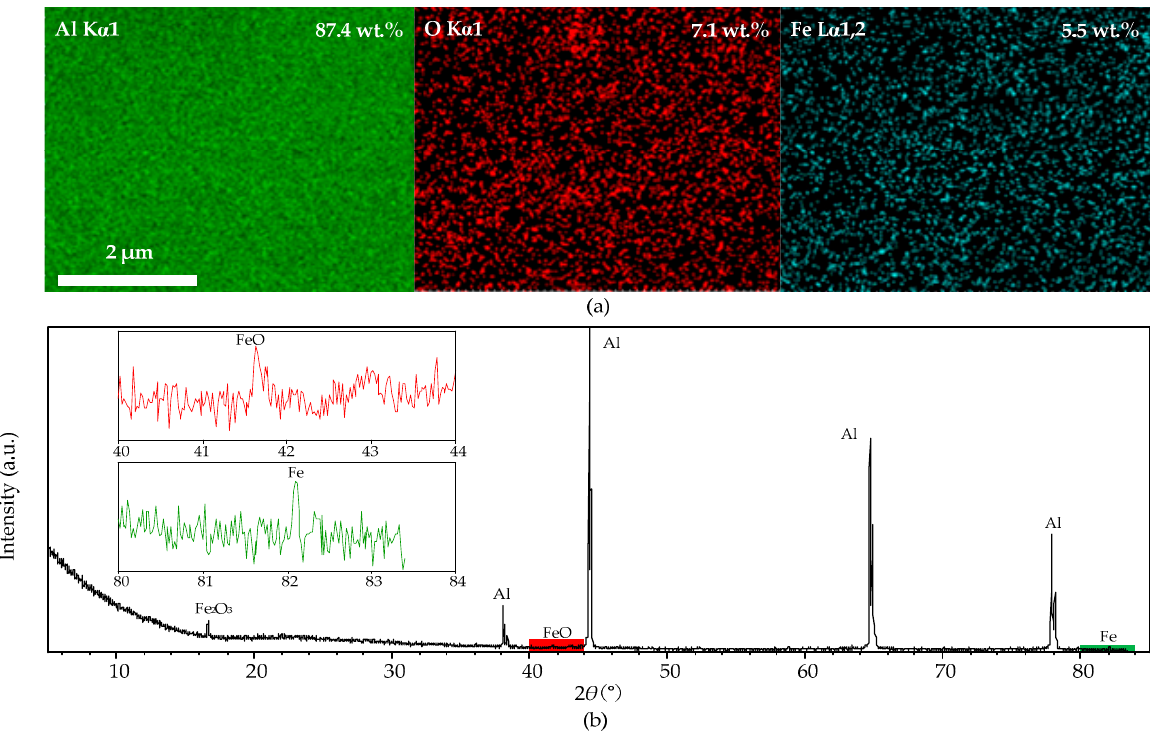
Figure 10. The EDS mapping and XRD spectra of the original foil after cleaning process, ( a ): EDS mapping micrograph; ( b ): XRD spectra.